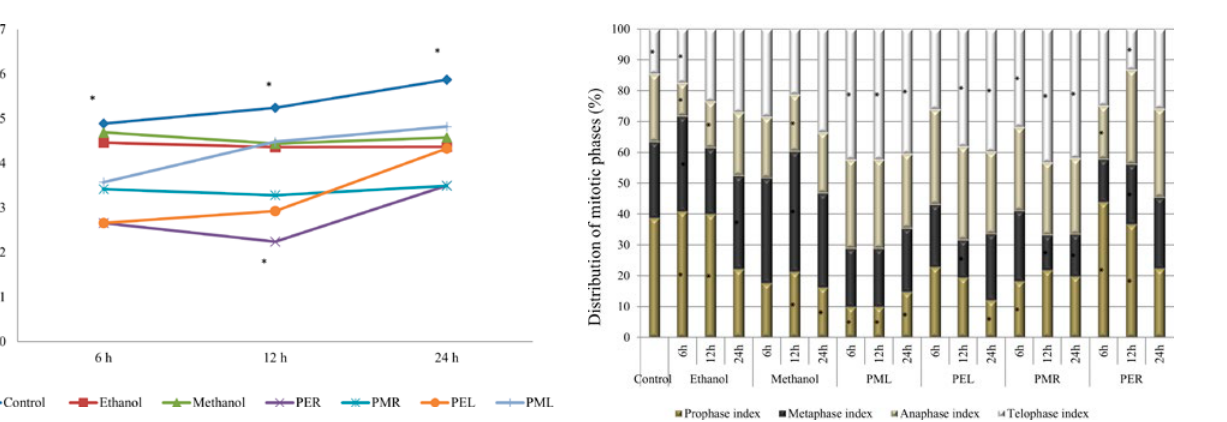
Fig. 4. The influence of the alcoholic extract of the rhizome and leaves of Polystichum setiferum (Forssk.) Moore ex Woyn. on the distribution of the mitotic phases in the meristematic root cells of Allium cepa L. (*interpretation of the significance of the differences, by means of the Tukey test,